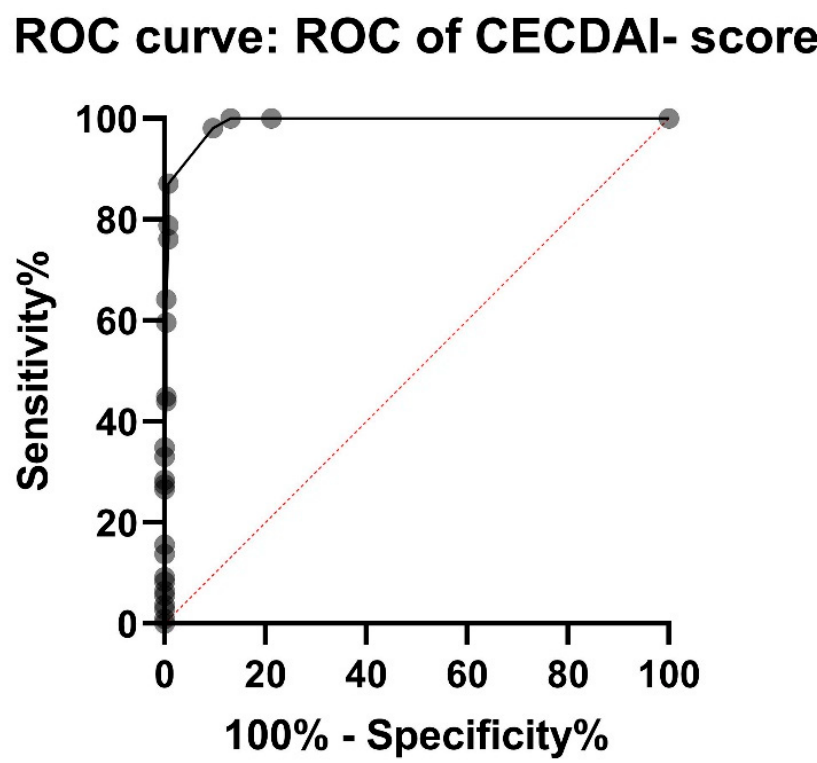
Figure 3. ROC (receiver operating characteristic) curve for CECDAI (Capsule Endoscopy Crohn’s Disease Activity Index) shows AUC (area under curve) of 0.99. Sensitivity and specificity were the highest between CECDAI-score of 2.5 and 3.5, suggesting a cut-off-value of 3 for small bowel Crohn’s disease.